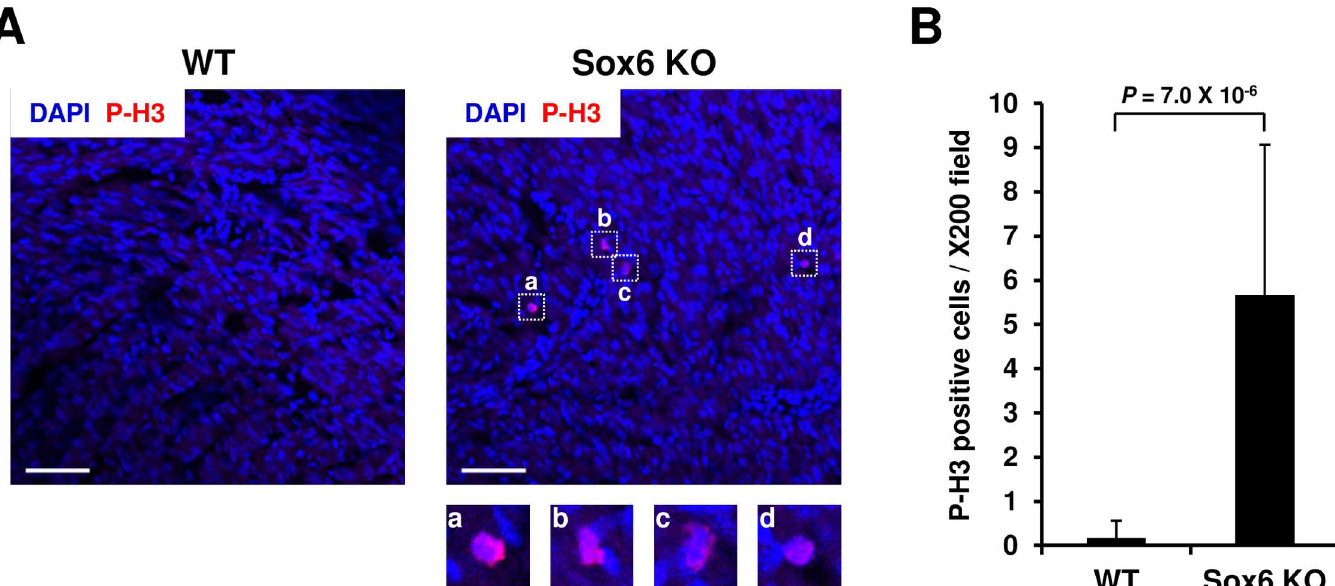
Fig 3. Sox6 KO mice still contain proliferating cells in the ventricle at postnatal day 7. (A) Representative views of immunofluorescence images from wild type (WT) and Sox6KO (Sox6 f/f ; MCK-Cre) ventricles. Cryosections of postnatalday 7 (P7) ventriclesfrom WT and Sox6KO mice were stainedwith antibodyagainst phosphorylated histoneH3 (P-H3) (red) and DAPI (blue). Magnifiedviews of P-H3 positive cells (a-d) were also shown for the Sox6 KO cryosection. Scale bars: 50 μ m. (B) Quantificationof P-H3 positive cells. P-H3 positive cells were counted on WT and Sox6 KO immunofluorescenceimages (12 images each) and represented as mean ± s.d. per X200 field covering approx. 0.4 mm 2 (630 μ m X 630 μ m).